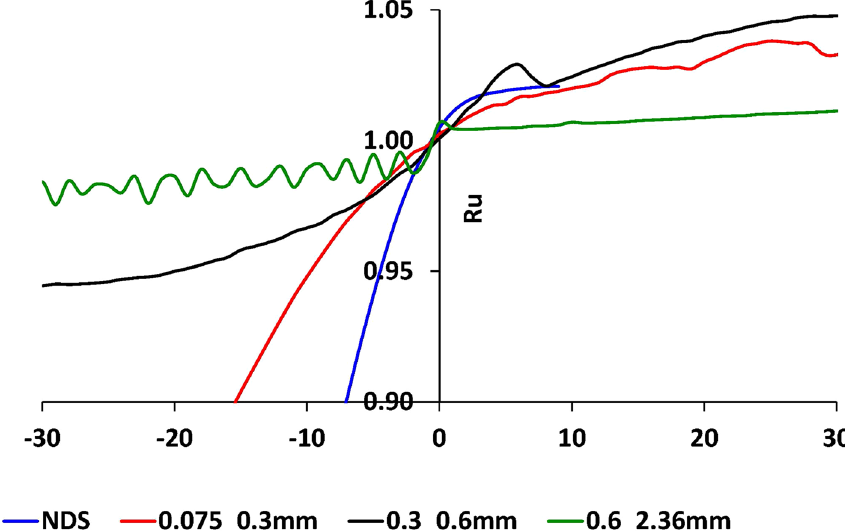
Figure 4. The changes of excess pore pressure vs. the number of vibration cycles N cyc for four sand samples under study, the X-values is the number of vibration cycles while 0 when the R u value is reached to 1 (the negative value of N cyc means the state before the liquefaction point while the positive values after the liquefaction point), the Y-axis is the value of excess pore pressure ratio R u . The blue, green, black, and red lines are for natural dune sand, fractions 2.36–0.6, 0.6–0.3, 0.3–0.075 mm,